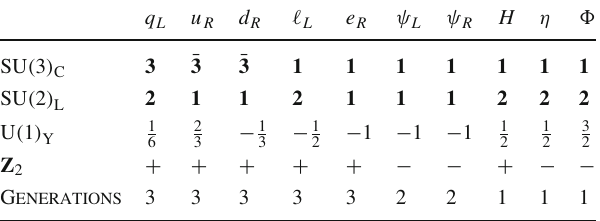
Table 1 Particle content of the model. q L , (cid:5) L , u R , d R , e R and H are the usual SM fields q